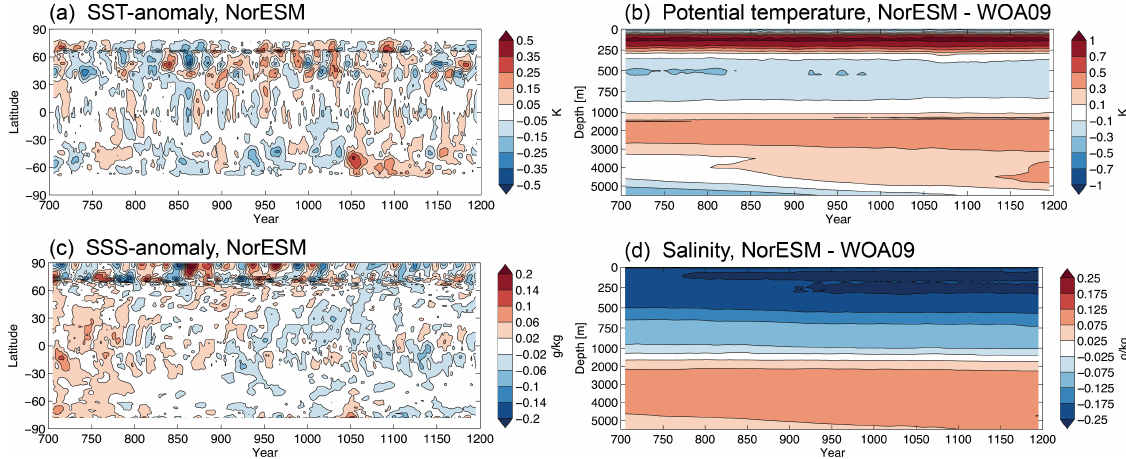
− 1 ) where the corresponding zonal time- Fig. 3. Latitude-time Hovm ¨ oller diagrams of (a) annual, zonal mean SST (K) and (c) SSS Fig. 3. Latitude–time Hovm¨oller diagrams of (a) annual, zonal mean SST (K) and (c) SSS (g kg means have been subtracted, and depth–time Hovm¨oller diagrams of (b) global mean ocean potential temperature (K) and (d) salinity (g kg − 1 ) presented as anomalies compared to World Ocean Atlas 2009 (WOA09; Locarnini et al., 2010; Antonov et al., 2010) annual mean potential temperature and salinity. All panels are based on years 700–1200 of NorESM piControl, time filtered with a 10yr running mean. Note the non-linear scaling with depth in panel (b) and (d)